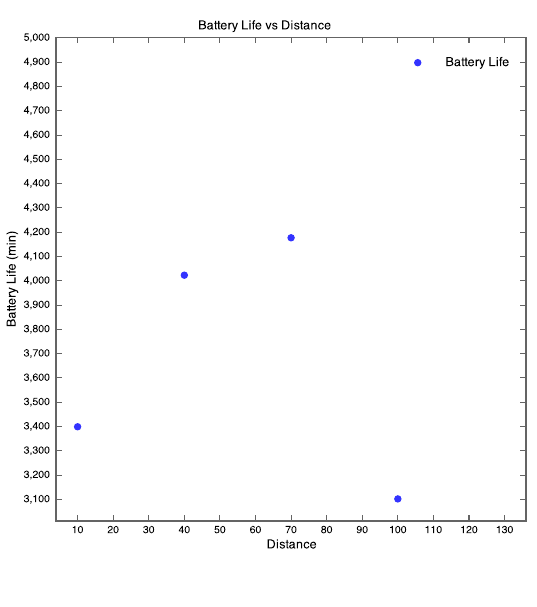
Figure 8. Battery Lifetime for Experiment